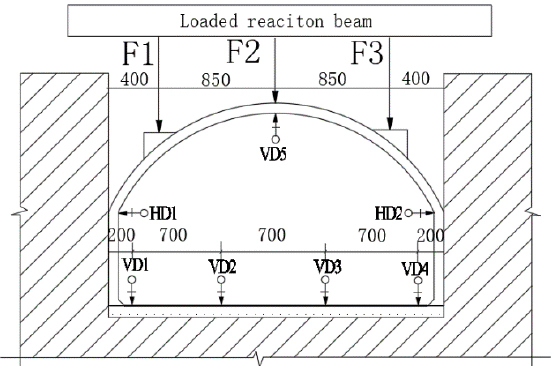
Figure 6. Displacement measuring points. F1 is the loading point at the arch quarter span; F2 is the loading point at the midpoint of the arch; F3 is the loading point at the three-quarter arch span; VD1, VD2, VD3 and VD4 are bottom vertical displacement measuring points; VD5 is the vertical displacement measuring point of the midpoint of the arch; HD1 and HD2 are horizontal displacement measurement points on both sides of the arch foot.